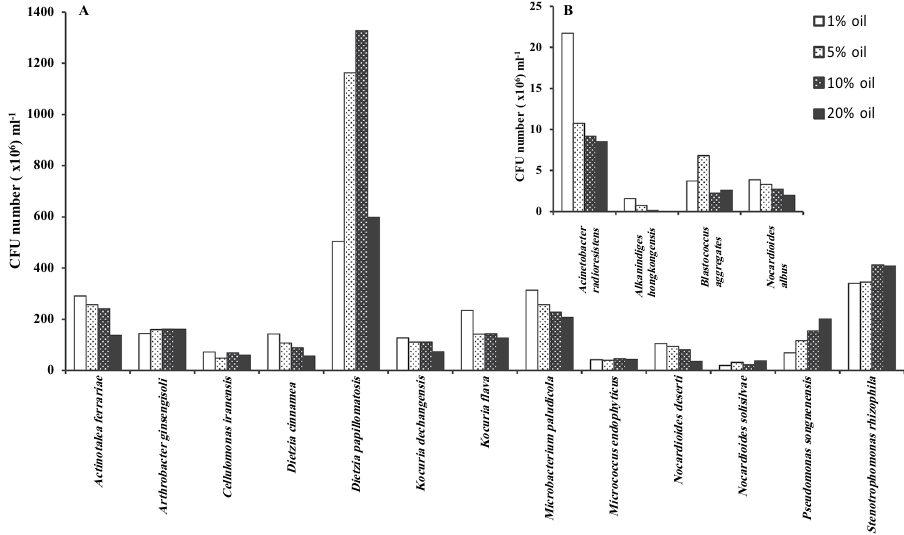
Figure 3. Oil-tolerance of 17 hydrocarbonoclastic isolates. ( A ) strains with highest tolerance; ( B ) strains with less